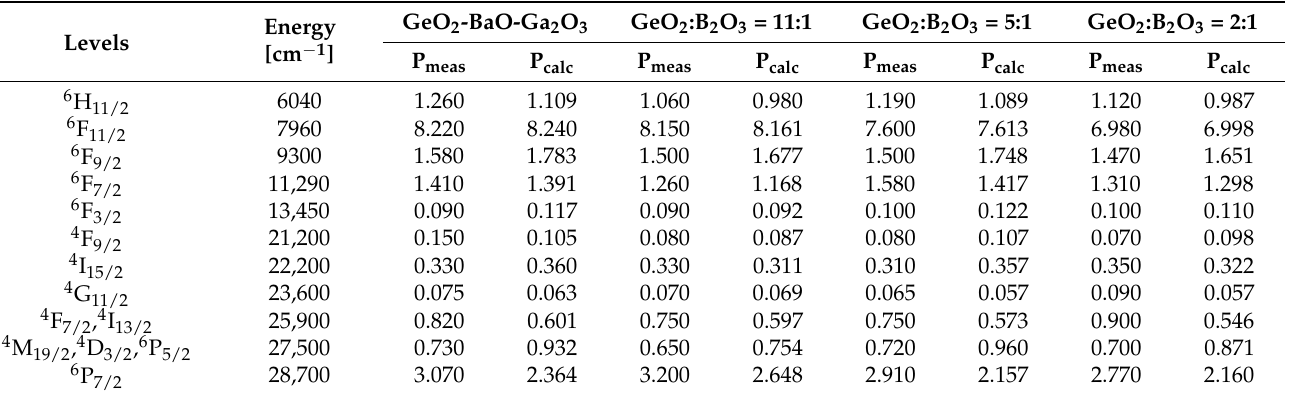
Table 3. Measured and calculated oscillator strengths (P × 10 −6 ) for Dy 3+ ions in GeO 2 -BaO-Ga 2 O 3 glass and mixed borogermanate glasses with GeO 2 :B 2 O 3 = 11:1, 5:1 and 2:1.